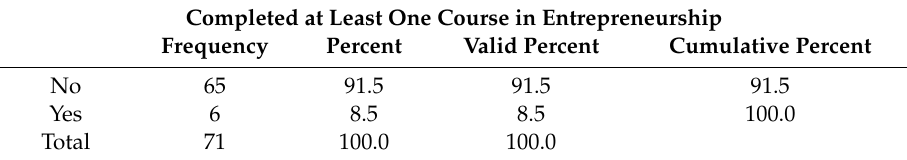
Table 3. Knowledge and Skills ANOVA Table for the Hackathon Event.